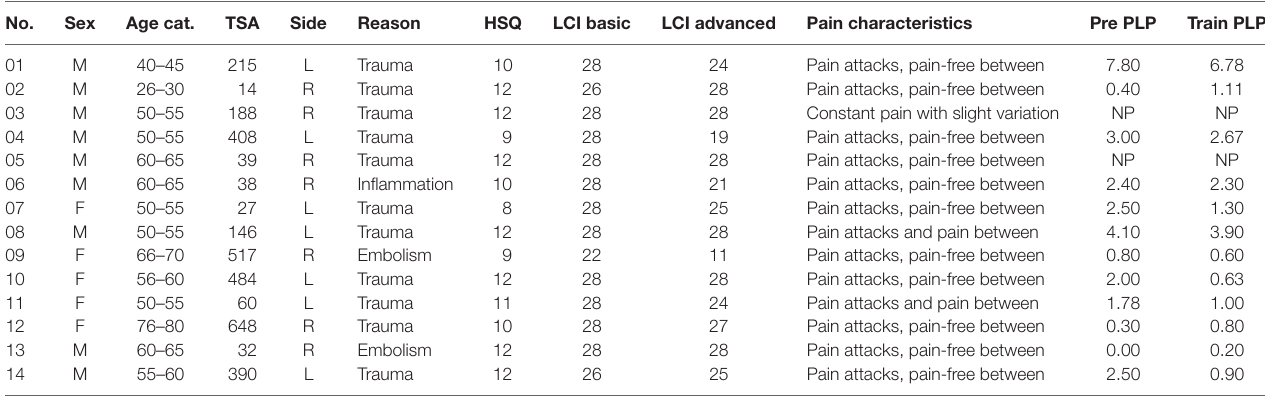
Table 1 | Demographic and clinical characteristics of patients. age